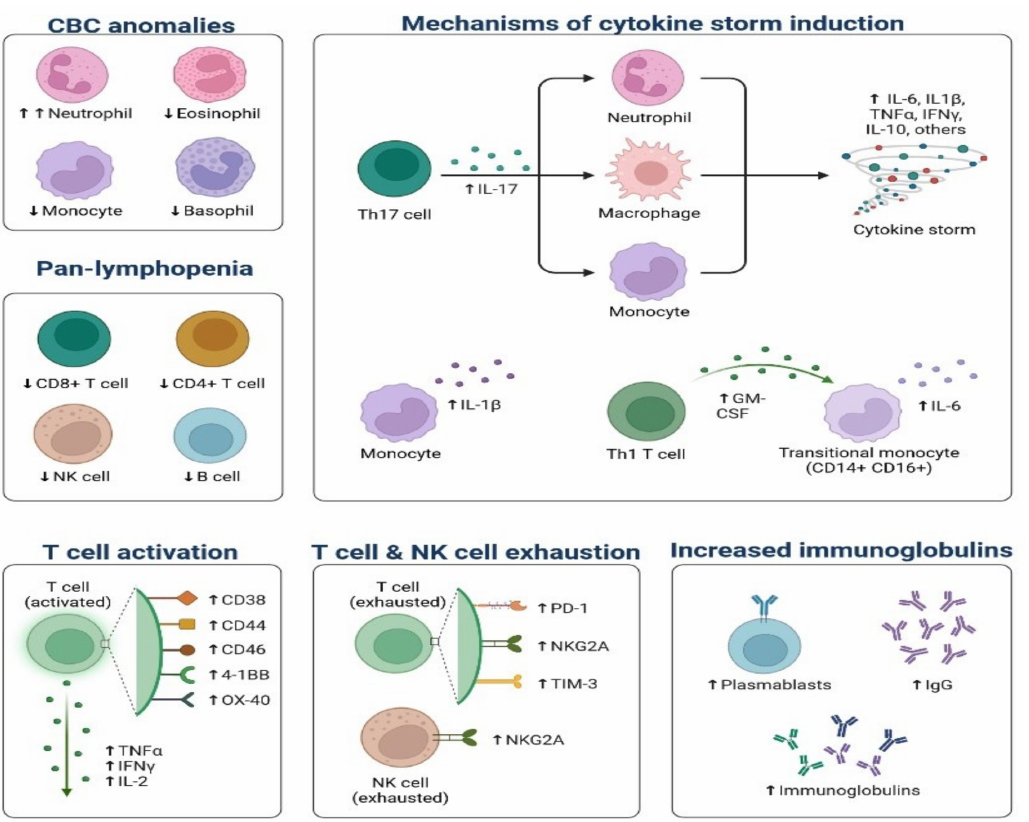
Figure 8. Recruitment of T and B Cells by APCs: Once they reach the target tissue, killer T cells detect specific virus fragments on the surface of infected cells and destroy them, eliminating virus factory. Antibodies secreted by B cells bind to the surface of the virus and block host entry (neutralizing antibodies).